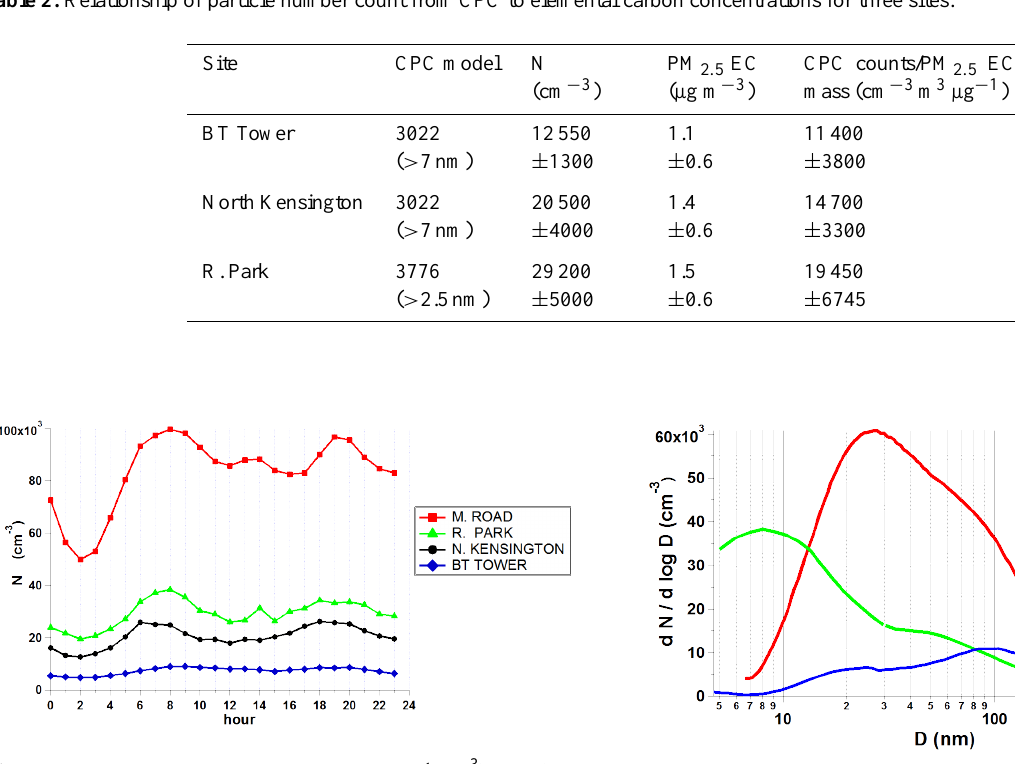
Fig. 3. Average particle size distributions (mobility diameter,nm)